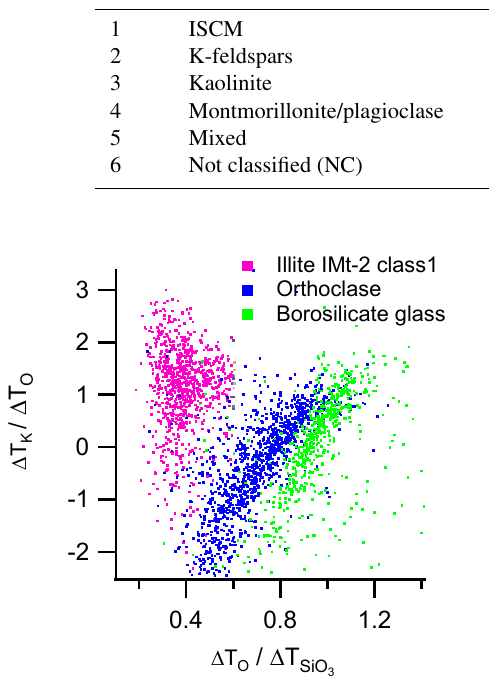
Figure 12. Relative ion arrival times in positive ion with respect to relative ion arrival times in negative ion. Borosilicate glass and orthoclase feldspar polydisperse particles and the ISCM fraction (class 1) of illite